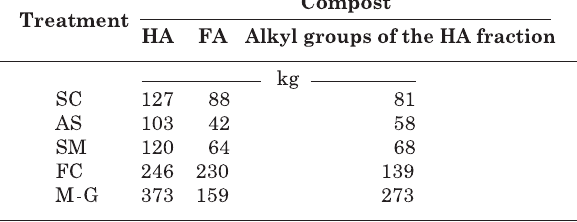
Table 3. Estimates of the quantitative levels